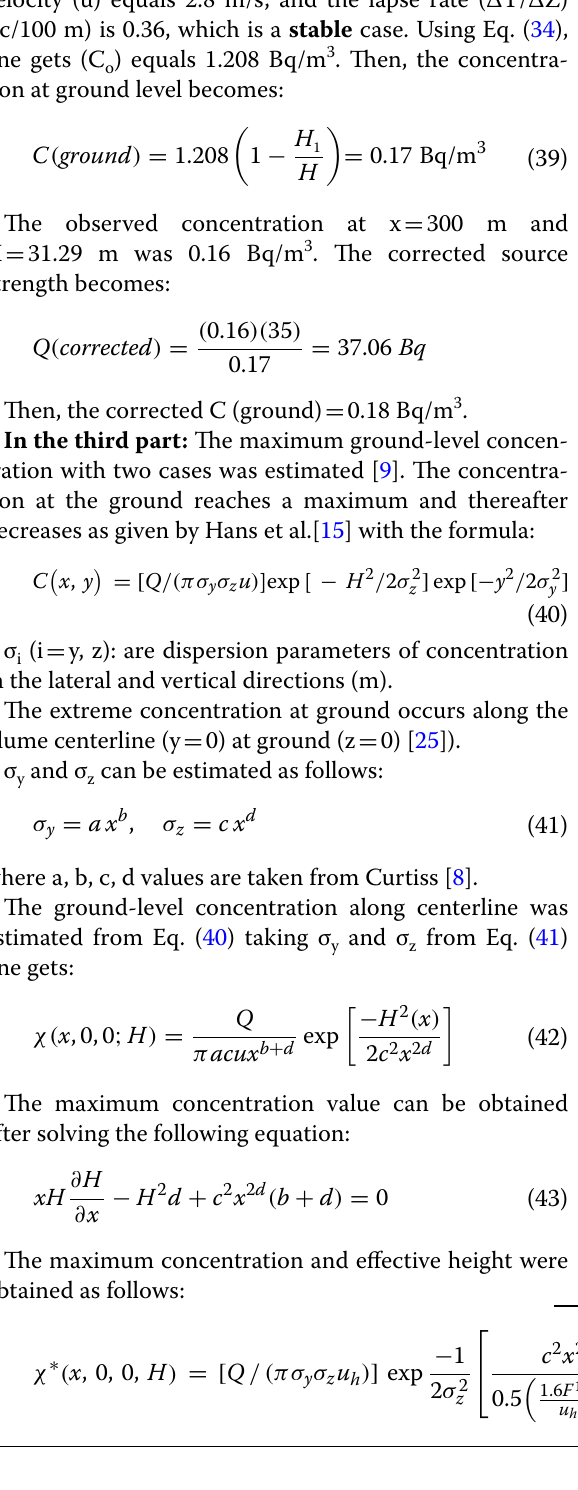
7 First: the effective height as a function of x A—Unstable or neutral